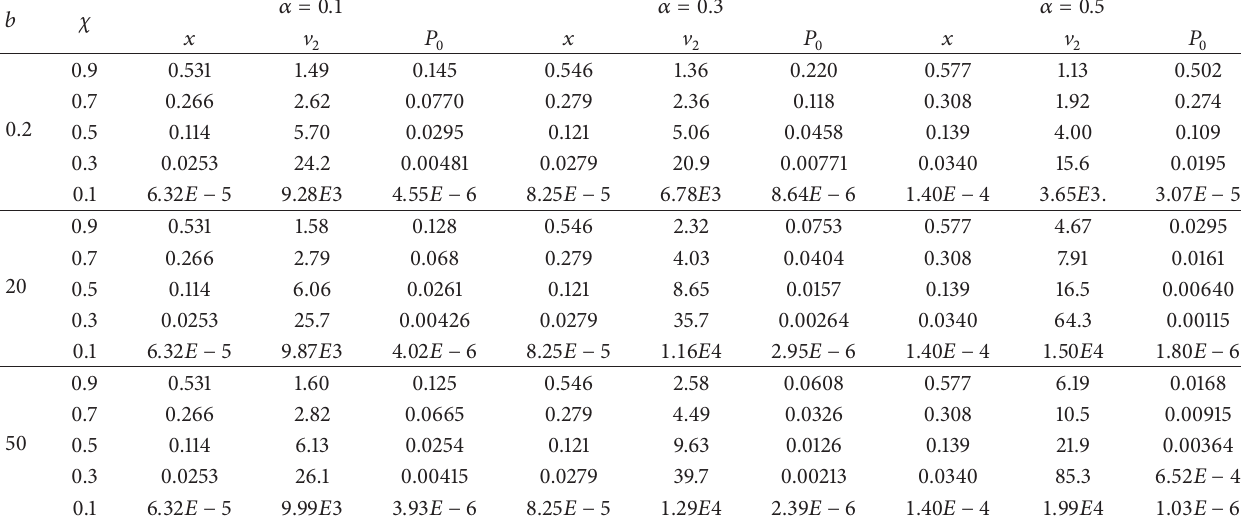
Table 1: State quantities at phase transition endpoints with different parameters 𝛼 and 𝑏 as 𝑑 = 5 , 𝑄 = 1